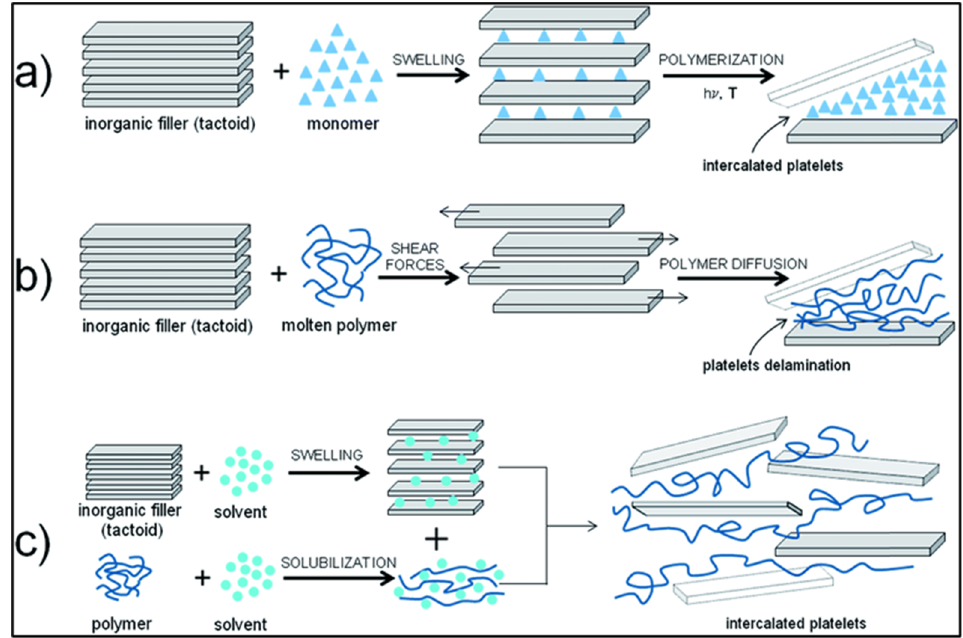
Figure 4. Synthesis of nanocomposites ( a ) in situ polymerization, ( b ) melt processing, and ( c ) exfo- liation adsorption. Adopted from [114] (CC BY).